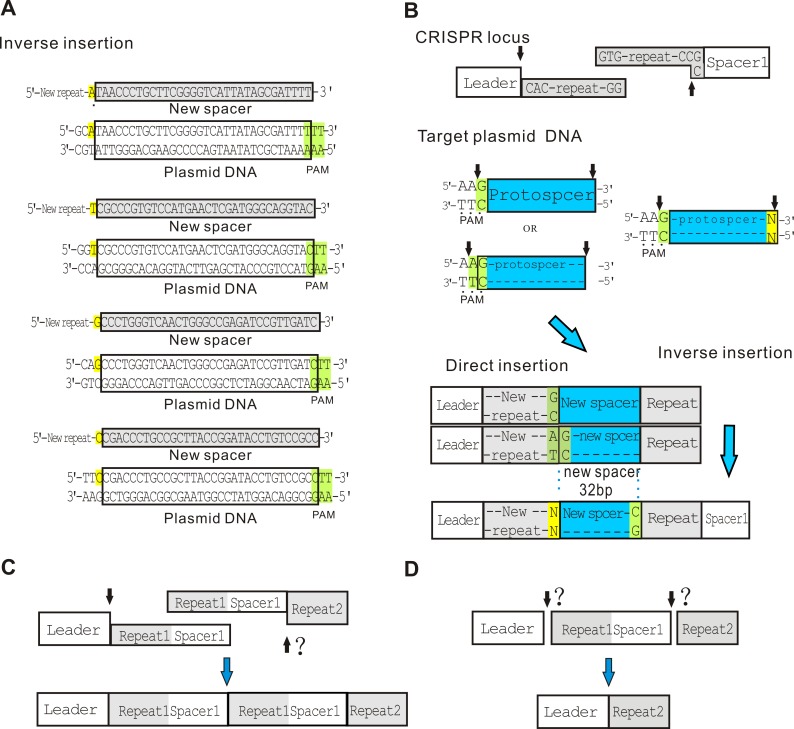
Irregular acquisitions observed in type I-E system in S. avermitilis.(A) Inverse insertion causes the differentiation of the last base of the new repeat. Protospacers from plasmid DNA and the corresponding new spacers are shown. The last base (yellow) of the new repeat corresponds to the first base (yellow) upstream of the protospacer. The PAM downstream of the protospacer is highlighted in green. (B) The proposed direct insertion and inverse insertion are shown. The leader and first spacer are represented by white rectangles. Repeat and protospacer are represented by a gray box and a blue box respectively. The black arrows indicate the proposed cleavage sites. Different instances of acquired fragments from target plasmid DNA are shown. The PAM upstream of the protospacer is underlined and the bases of PAM cleaved with protospacer are highlighted in green. The colors of inserted fragments from plasmid DNA are different from the original repeat sequences. New spacers are boxed, and sequence length is indicated below. (C) A CRSIPR II array with a new spacer that is a duplication of the original first spacer. The proposed cleavage sites are indicated black arrows. (D) A CRISPR II array showing loss of the first repeat and spacer. The possible cleavage sites are indicated with black arrows and question marks.